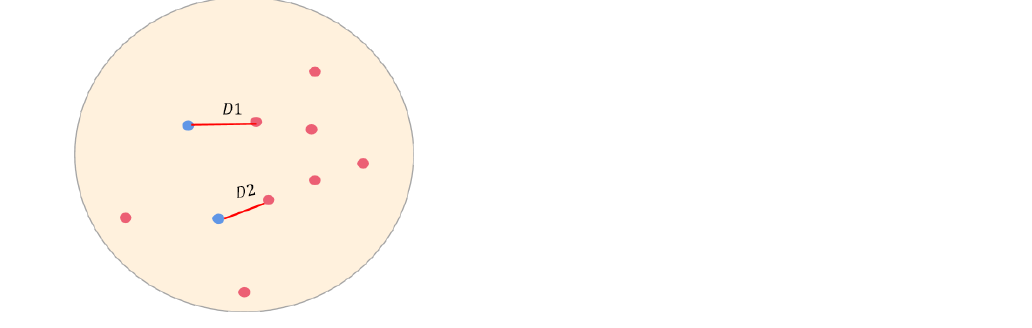
Table 2. Change in crime distance and change in risk